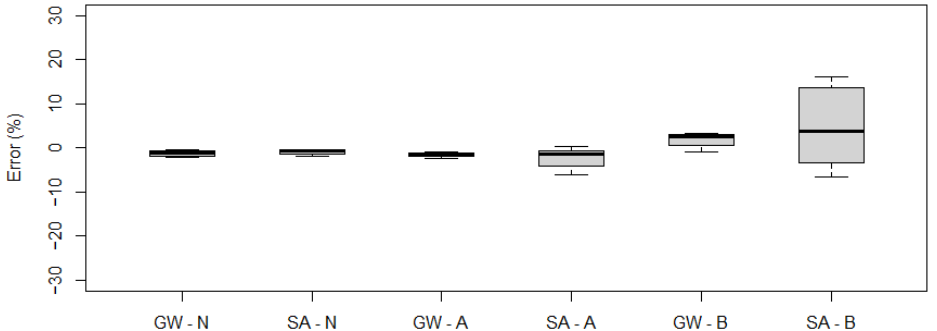
Figure 19. Measurement errors obtained for gross weight (GW), single axle (SA) for a two-axle vehicle: N—runs at constant speed, A—accelerating, and B—braking (the top and bottom of each box represent the 75th and 25th percentile values, whiskers show the minimum and maximum, the horizontal line represents the median).